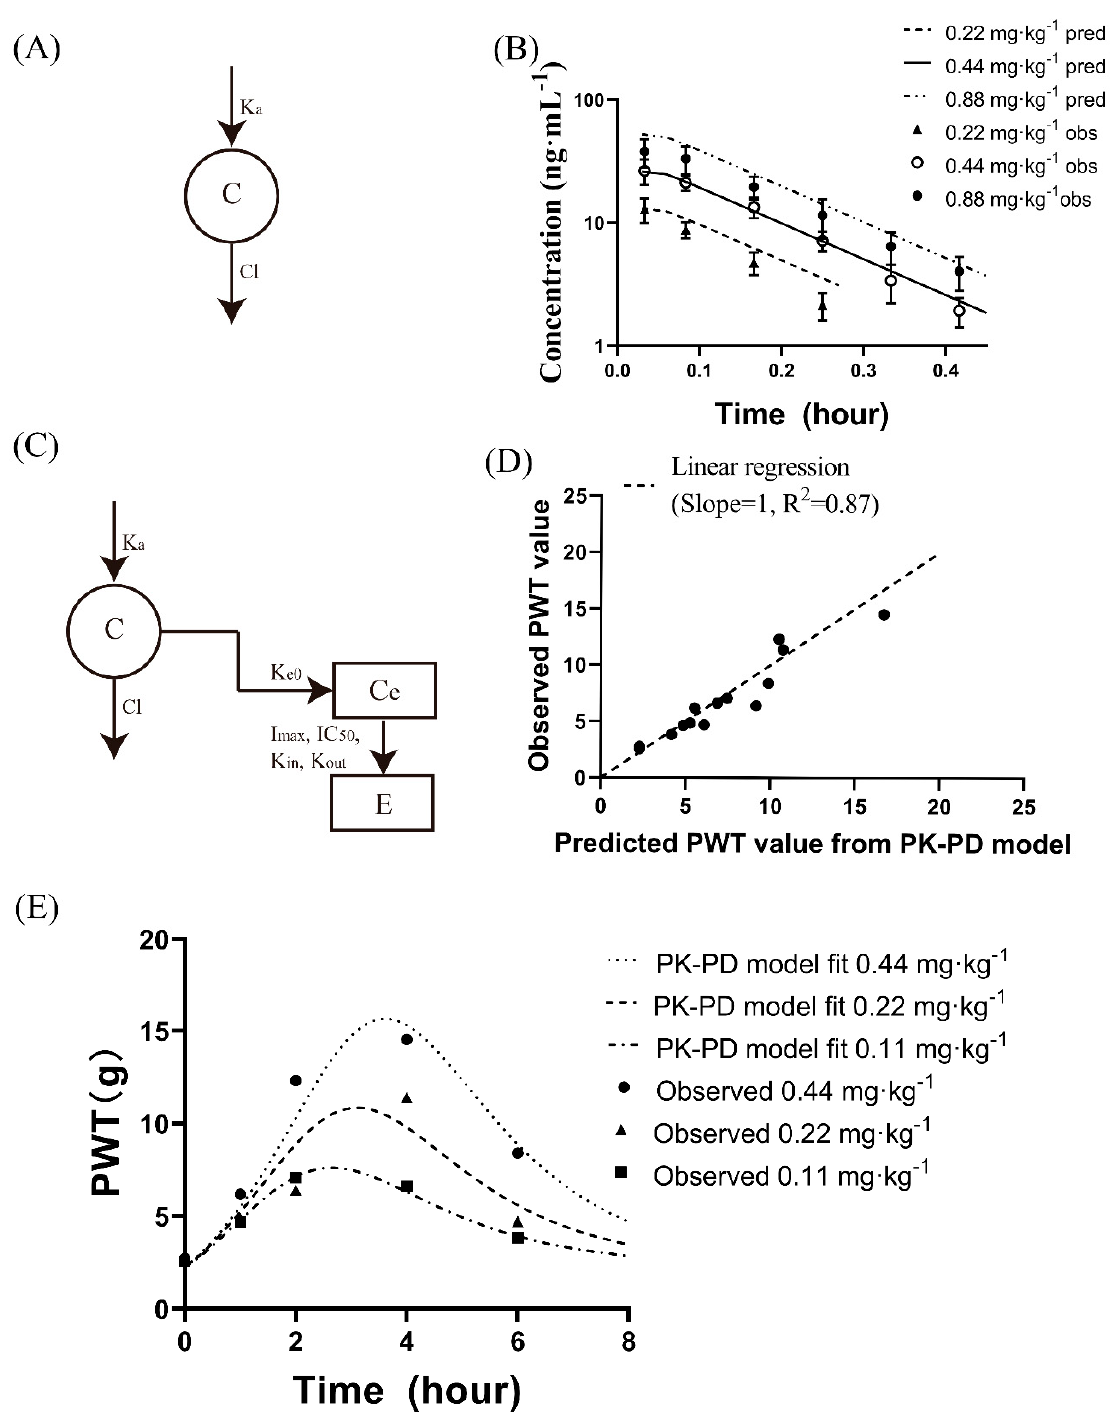
Figure 4. PK-PD modelling for GeXIVA[1,2]. ( A ) Schematic of the one-compartmental model used to fit the concentration–time profiles of GeXIVA[1,2] derived from the concentration–time profiles after the IM administration of 0.44 mg·kg − 1 GeXIVA[1,2]. ( B ) Observed concentration–time profiles versus predicted concentration–time profiles of GeXIVA[1,2] after the IM administration of 0.22, 0.44, and 0.88 mg·kg − 1 GeXIVA[1,2] in rats. ( C ) Schematic overview of the PK-PD model for GeXIVA[1,2]. ( D ) Observed PWT value in rats versus predicted PWT value from the PK-PD model. R 2 for the linear regression (slope = 1) was 0.87. ( E ) PK-PD model fitted PWT-time profiles versus observed PWT-time profiles after the IM administration of 0.11, 0.22, and 0.44 mg·kg − 1 GeXIVA[1,2]. The parameter estimates were as follows: Ka, 68.19 h − 1 ; V, 12.83 L·kg − 1 ; CL, 86.22 L·h − 1 ·kg − 1 ; Ke0, 1.12 h − 1 ; K in , 1.21 h − 1 ; K out , 0.53; I max , 2.16; and IC 50 , 0.16 ng·mL − 1 . The PWT values at 1, 2, 4, and 6 h postdosing were simulated, and the AUC of the PWT was calculated (Table S2). The observed PWT values and the predicted PWT values were matched well (Figure 4E). The ratios of the predicted-to-observed PWT values were within 0.69–1.22-fold range, and the AUC of the effect was within 1.03–1.11-fold range for all three doses, indicating that the PK-PD model could adequately describe the PK-PD relationships (Figure 4E and